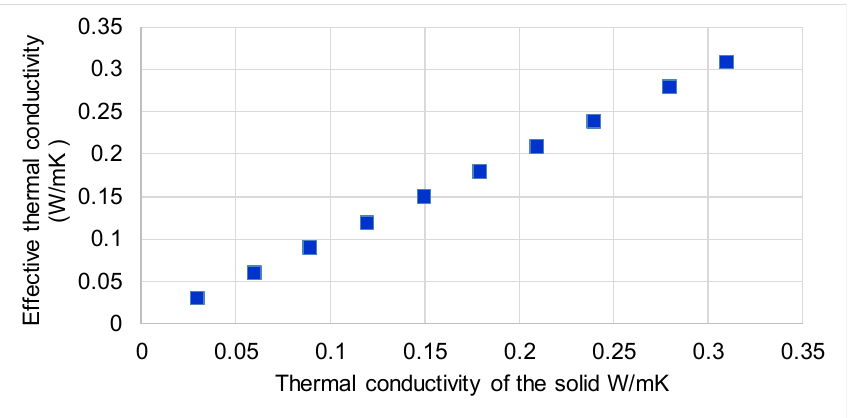
Figure 6. Variation of calculated effective thermal conductivity of the perforated panel as a function of the thermal conductivity of the solid.